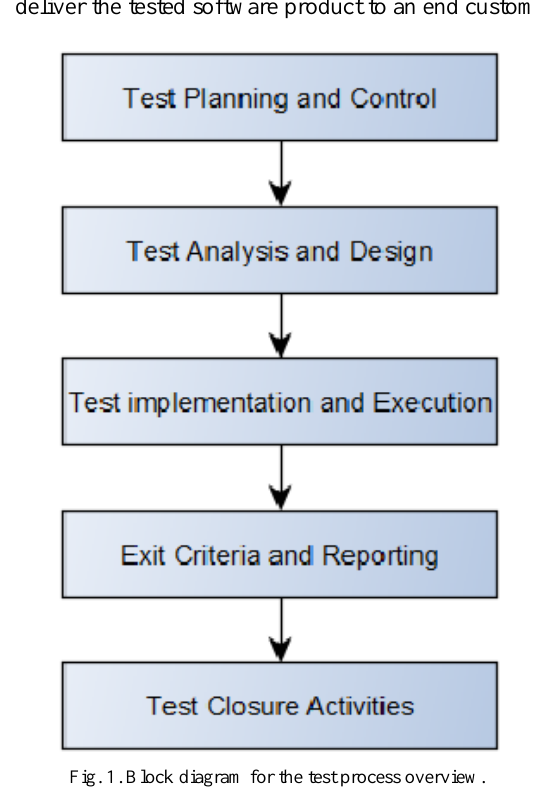
Fig. 1. Block diagram for the test process